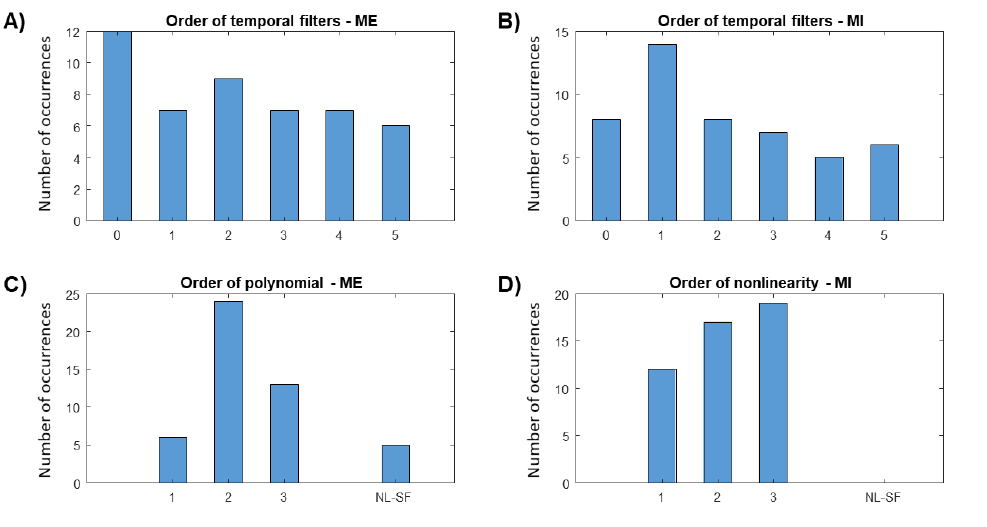
Figure 4. Histograms of orders of temporal filters ( A , B ) and order of polynomial non-linearity ( C , D ) of the filters selected to be applied on test data (majority voting on the outputs of three filters) for EEGs recorded during either motor execution (ME, panels A , C ) or imagination (MI, B , D ). NL-SF indicates the non-linear spatial filter, sometimes preferred over a polynomial non-linearity.